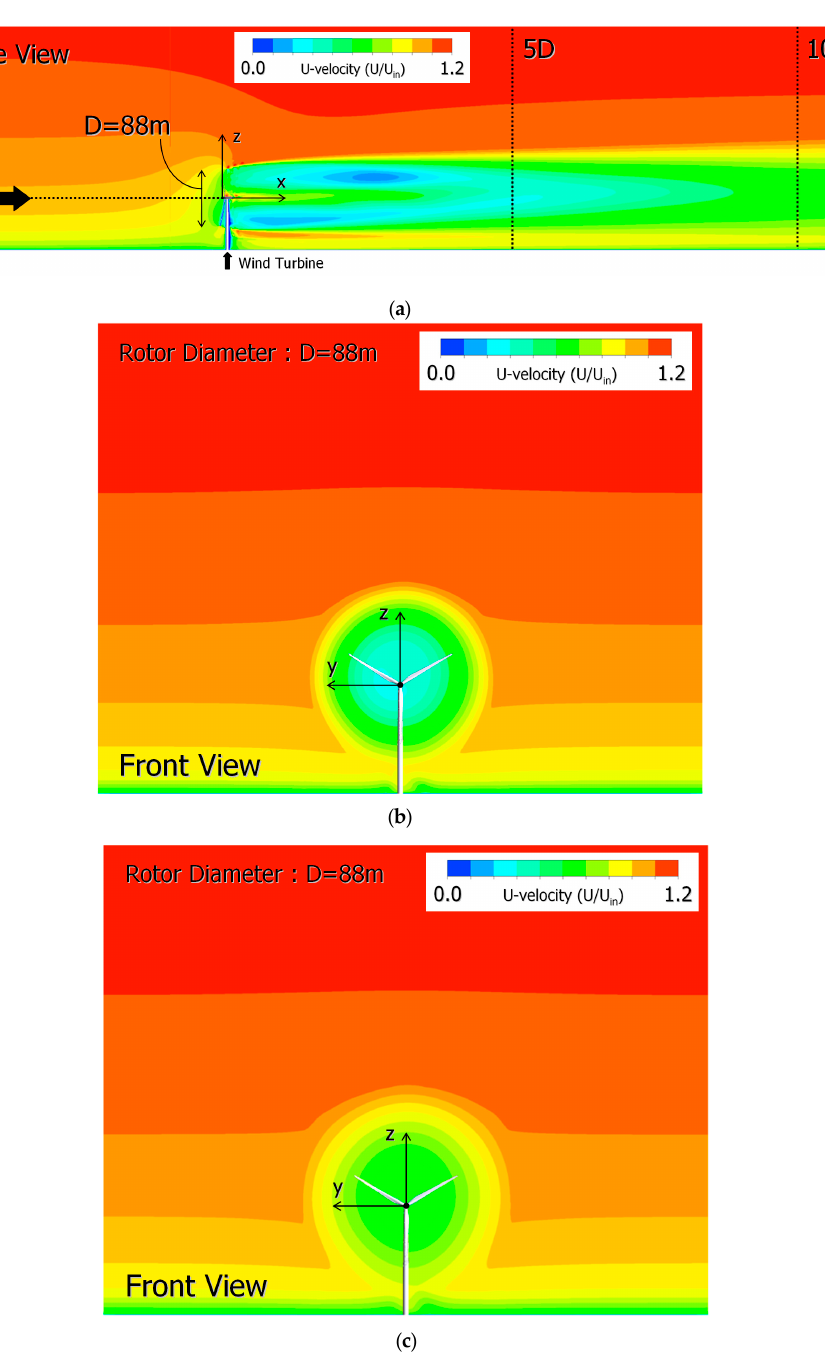
Figure 15. Simulation results for the real wind turbine and the spatial distribution of instantaneous U-velocity found by the fully resolved geometries combined with unsteady RANS approach by ANSYS(R) CFX(R) CFX. ( a ) Side view; ( b ) front view, x = 5D (near wake region); ( c ) font view, x = 10D (far wake region).